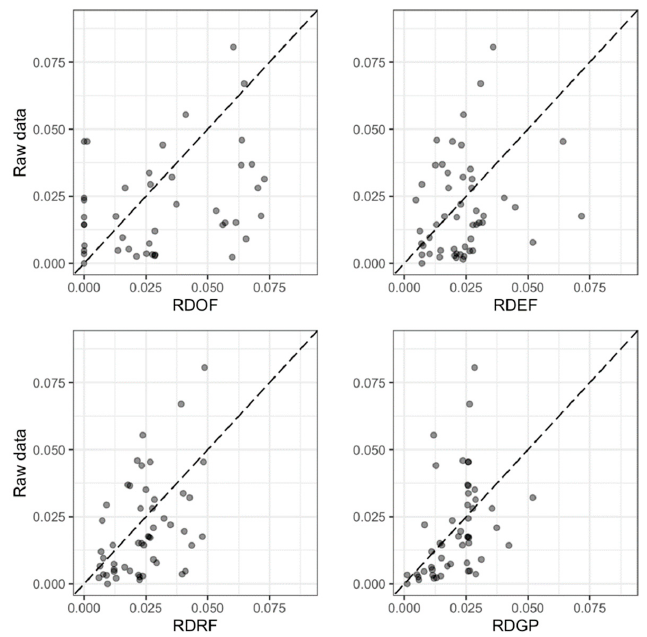
Figure 3. Predicted values for a random out-of-the-bag dataset using the optimal tuned parameters of each model versus observed values of bed load.